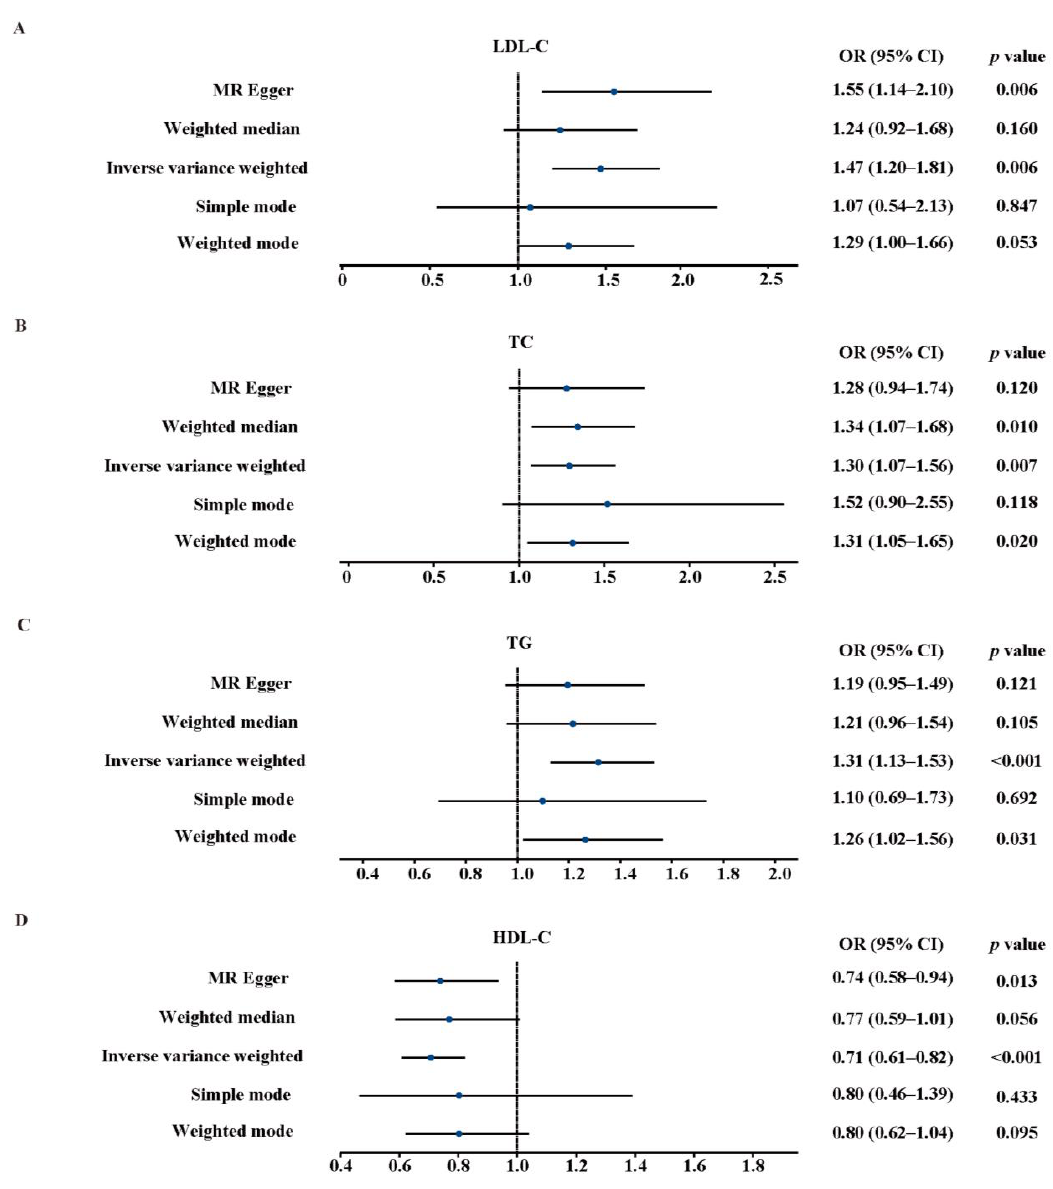
Figure 2. Associations between genetically predicted plasma levels of LDL-C ( A ), TC ( B ), TG ( C ) and HDL-C ( D ) and the risk of AA. LDL-C, low-density lipoprotein cholesterol; TC, total choles- terol; TG, triglyceride; HDL-C, high-density lipoprotein cholesterol; CI, confidence interval; OR, odds ratio. Table 2. Tests of pleiotropy of selected SNPs and heterogeneity between SNPs.